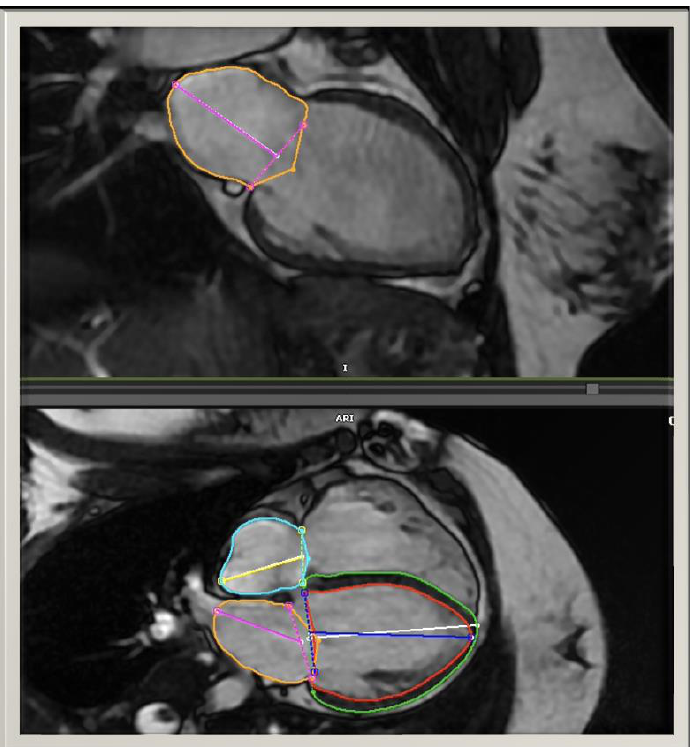
Figure 2. Automated LA volumes were measured in the biplane view and adjusted manually as needed. The RA volumes were measured in monoplane 4-chamber views.